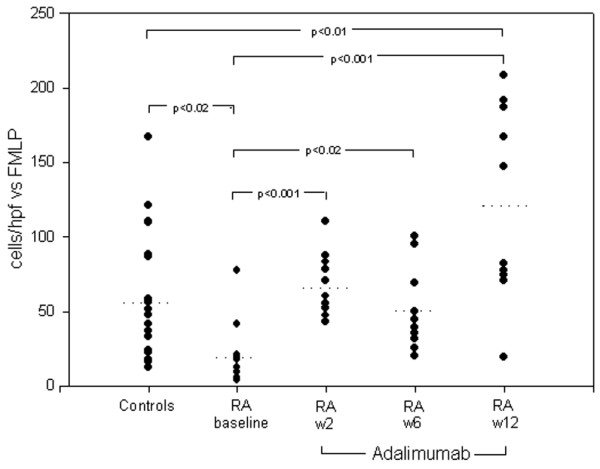
Neutrophils were obtained as described in the legend to Figure 1 and then tested for chemotactic responsiveness toward the chemoattractant N-formyl-methionyl-leucyl-phenylalanine (FMLP). The dotted lines indicate the mean values. RA, rheumatoid arthritis.